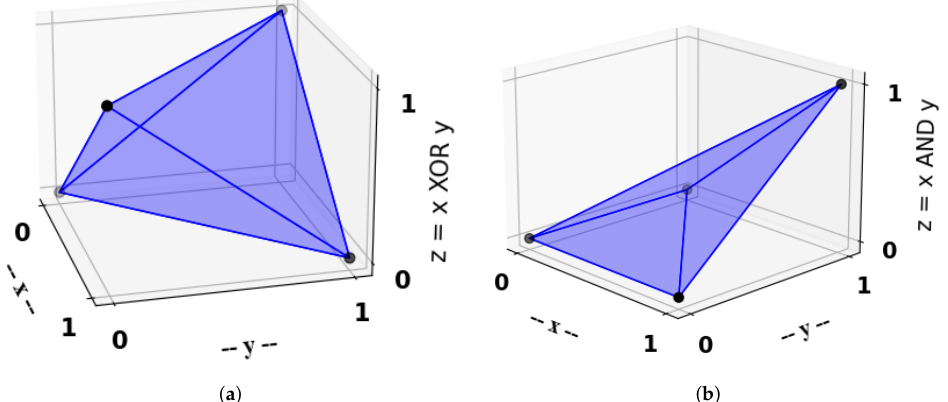
Figure 1. Examples of polyhedrons for bi-variant Boolean functions. ( a ) XOR function. ( b ) AND